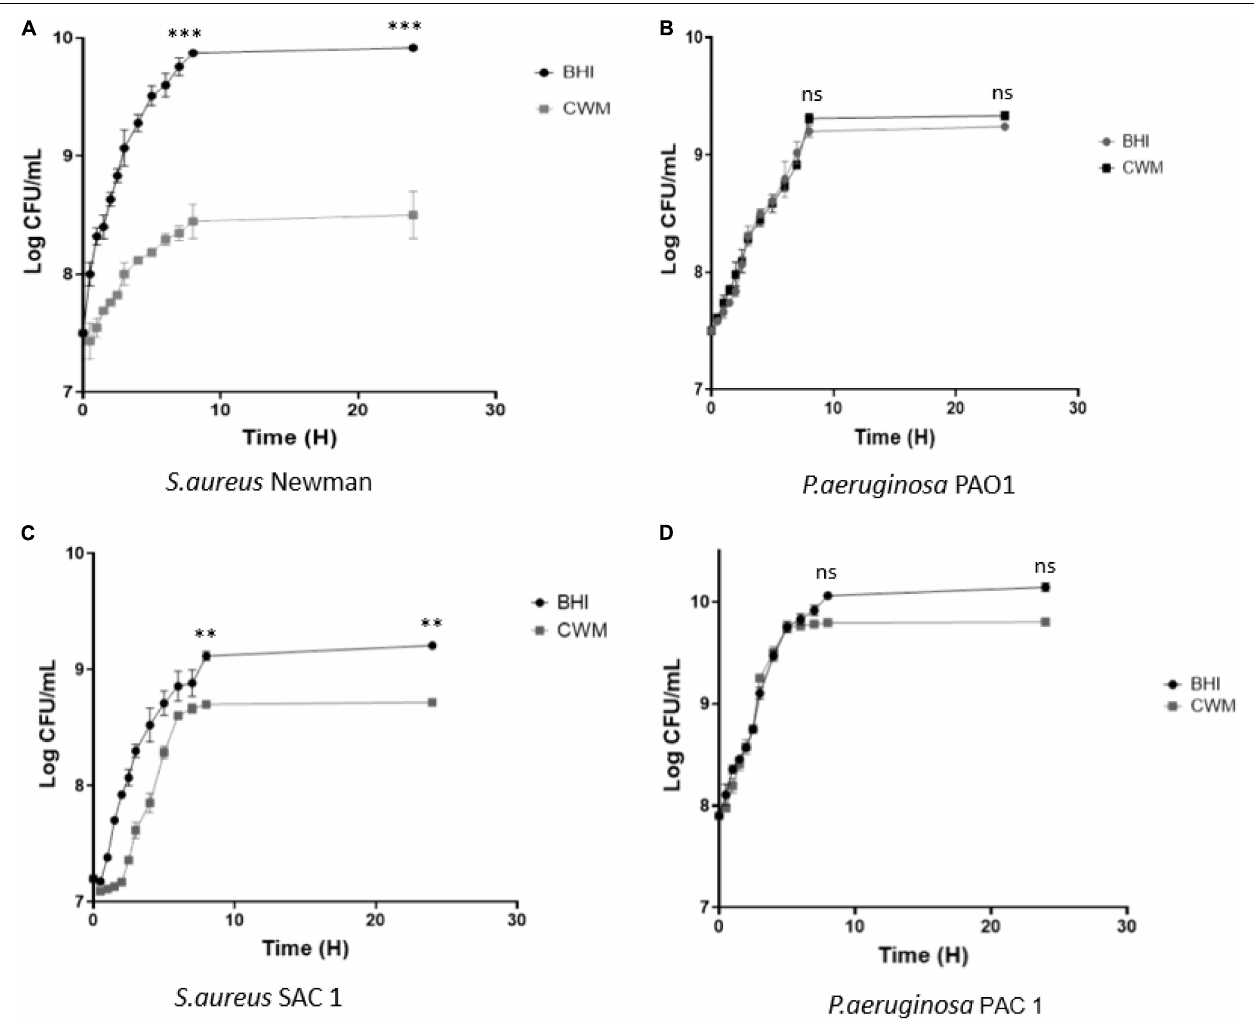
FIGURE 1 | Growth curves of reference (A,B) and clinical (C,D) strains of S. aureus and P. aeruginosa in CWM and BHI media. Cultures were sampled at the indicated time points, and the numbers of bacteria were estimated by CFU enumeration of P. aeruginosa and S. aureus on non-selective medium. Experiments were performed in three biological replicates; data points represent the average of these replicates, and error bars represent the standard deviation. Comparisons were performed with t -test. Significance was set to a p < 5%. ns, not significant; ∗∗∗ p < 0.001, ∗∗ p < 0.01.